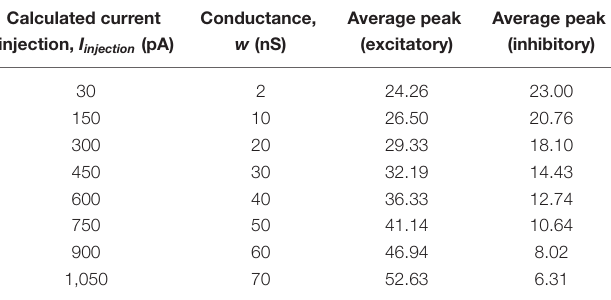
TABLE 3 | Average maximum number of spikes per time window when injecting excitatory or inhibitory current to the MNP. I injection shown is an approximation, calculated using Equation (5) where V m = − 45 mV and w is as defined in the